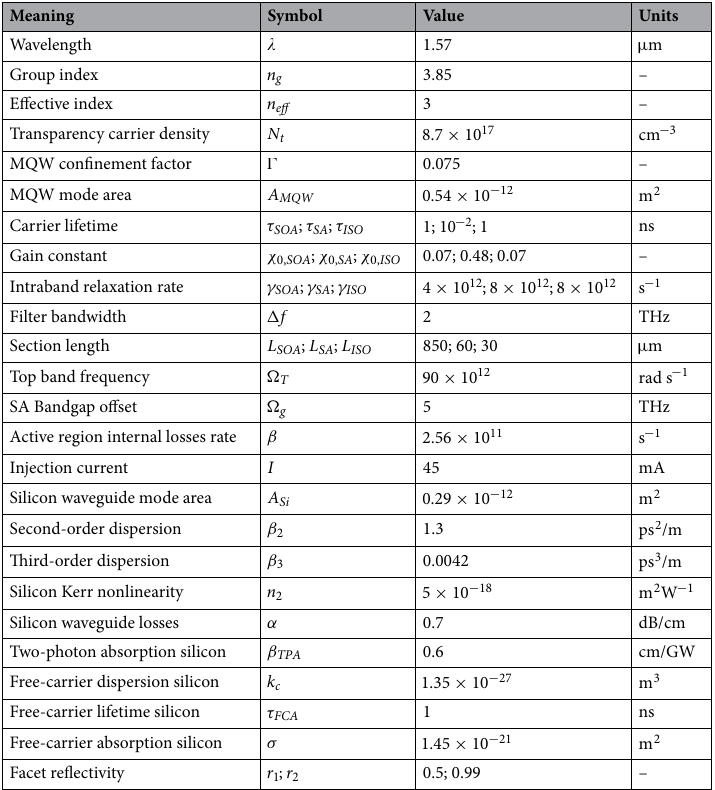
Table 1. Parameters used. SOA semiconductor optical amplifier, SA saturable absorber, ISO isolation region in between the SOA and SA.